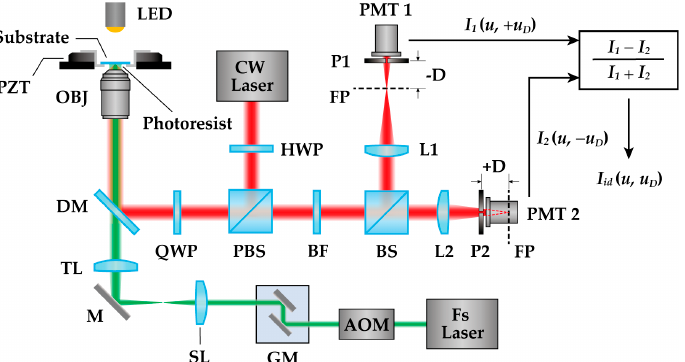
Figure 1. Schematic of the autofocus system based on IDCM. The re fl ected intensity response signals (red optical path) are collected by two PMTs to measure the defocus amount of the substrate. The excitation light (green optical path) emi tt ed from Fs Laser is used for TPL fabrication. The objective lens is applied to focus the incident light beam on the substrate and receive the re fl ected light simultaneously, and its focal length is much larger than the defocus amount of the substrate. So, h i ( ν , u ) ( i = 1, 2) can be expressed as